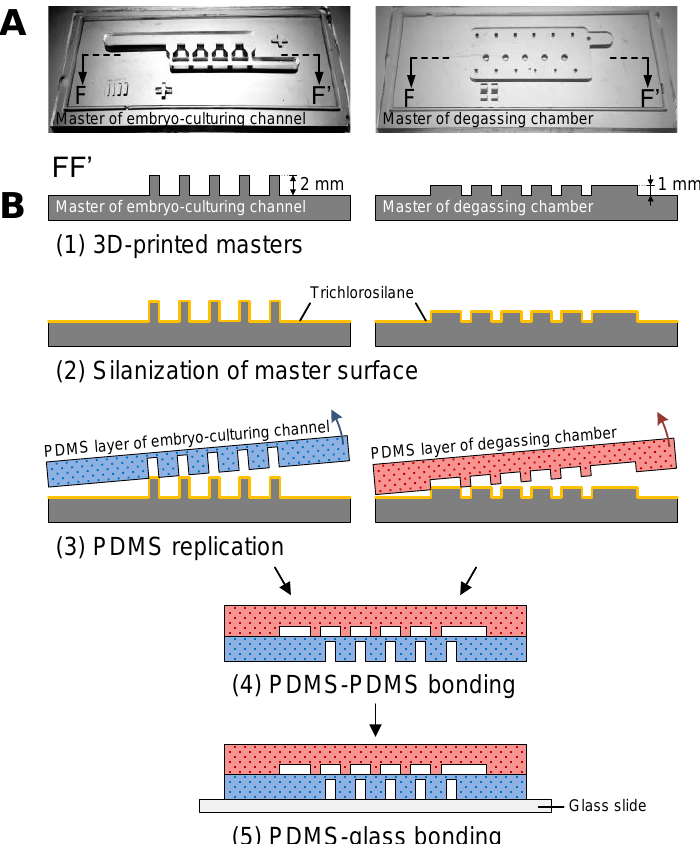
Figure 3. Fabrication process of the microfluidic device. ( A ) Photos of 3D printed masters for embryo-culturing channel and degassing chamber. ( B -1) Schematic side view along FF’ of Figures 1A and 3A. ( B -2) Surface silanization of masters with the trichlorosilane. ( B -3) PDMS replication from masters. ( B -4) Bonding the degassing chamber onto the embryo-culturing channel. ( B -5) Bonding the PDMS stamp onto the glass slide.